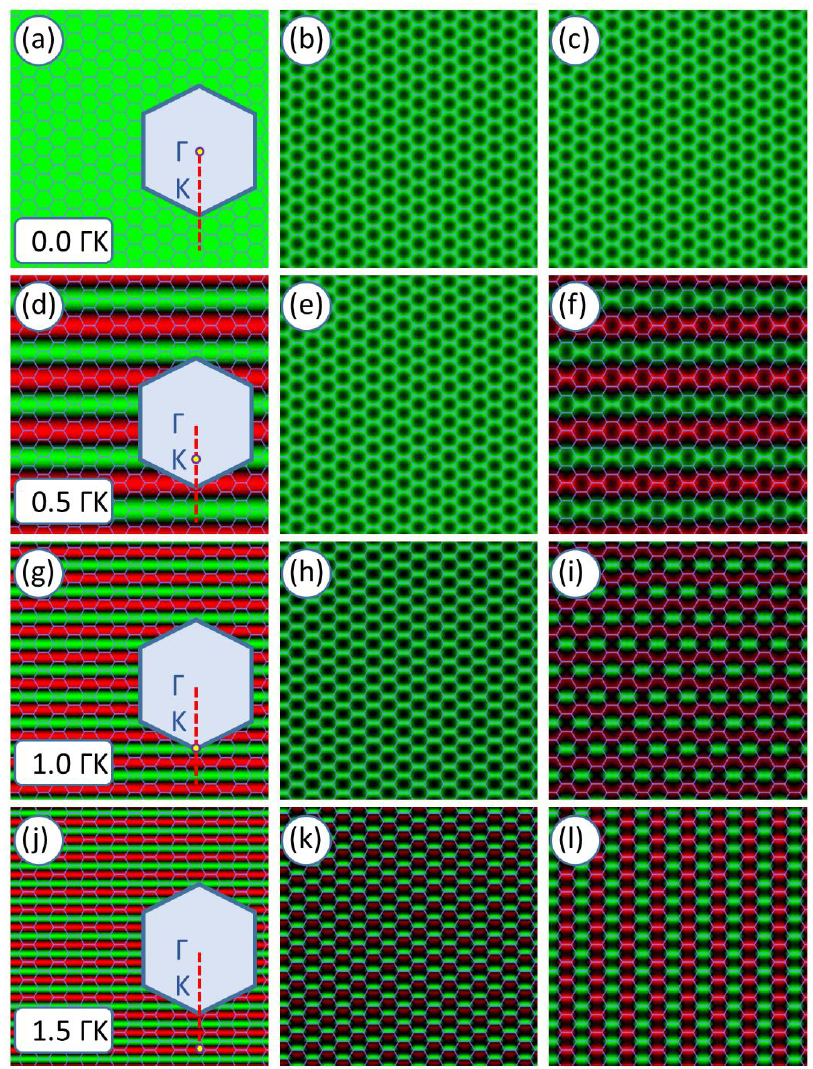
Figure 1. Construction of the graphene Bloch wave functions for different points along the Γ K line in the extended Brillouin zone. Left column: 𝑒 𝑖𝑘⃗⃗ 𝐵𝑙𝑜𝑐ℎ 𝑟⃗ . Middle column: 𝑢(𝑟⃗,𝑘 ⃗⃗ 𝐵𝑙𝑜𝑐ℎ ) . Right column: 𝜑(𝑟⃗,𝑘 ⃗⃗ 𝐵𝑙𝑜𝑐ℎ ) . See Section 2 for details. Real parts of the wave functions are shown, green is positive, red is negative. The graphene lattice is shown by blue lines. The insets in a, d, g, j show the position of 𝑘⃗⃗ 𝐵𝑙𝑜𝑐ℎ (yellow dot) relative to the Brillouin zone.